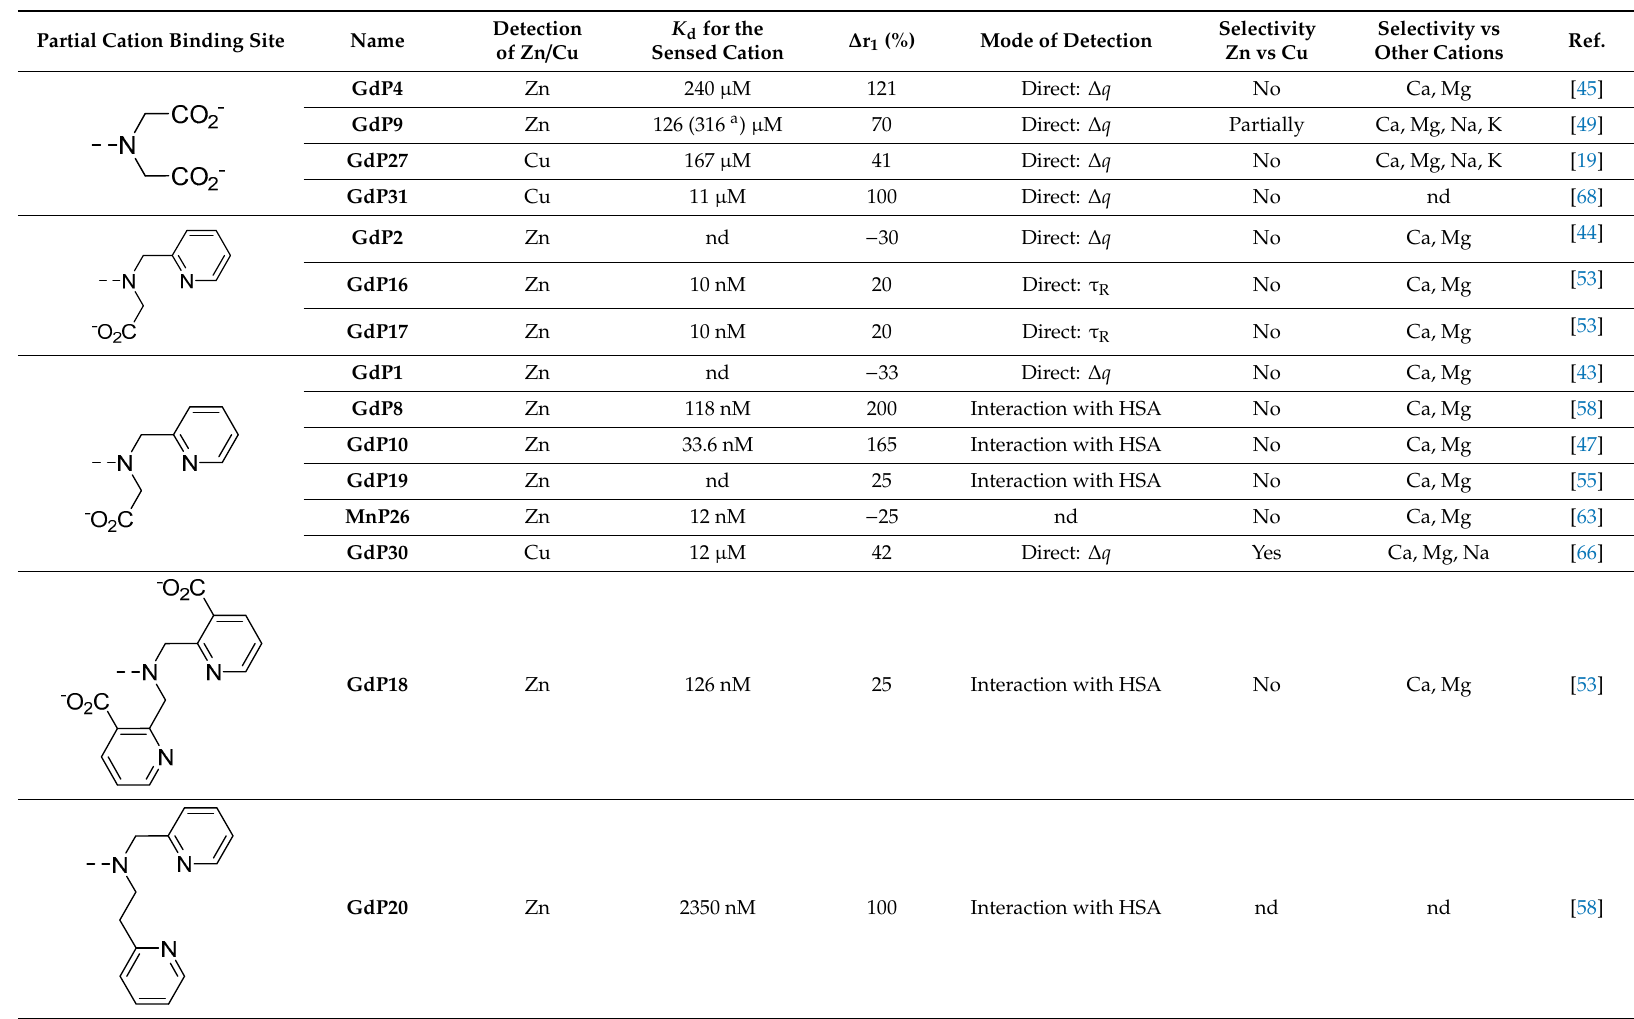
Table 1. Partial binding site, mode of detection, a ffi nity and selectivity of T 1 -based probes for Zn 2 + and Cu 2 + detection.